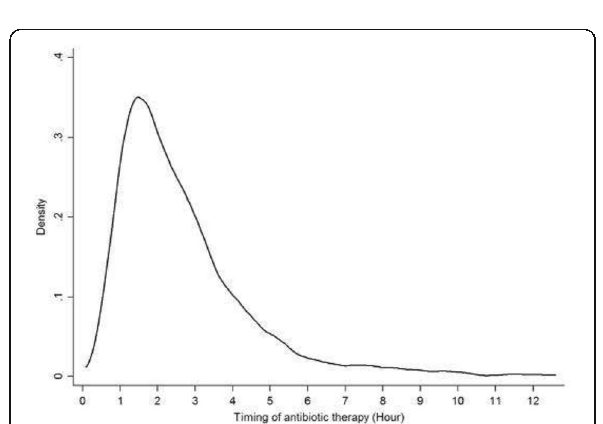
Fig. 2 (abstract 0256). Timing of antibiotic